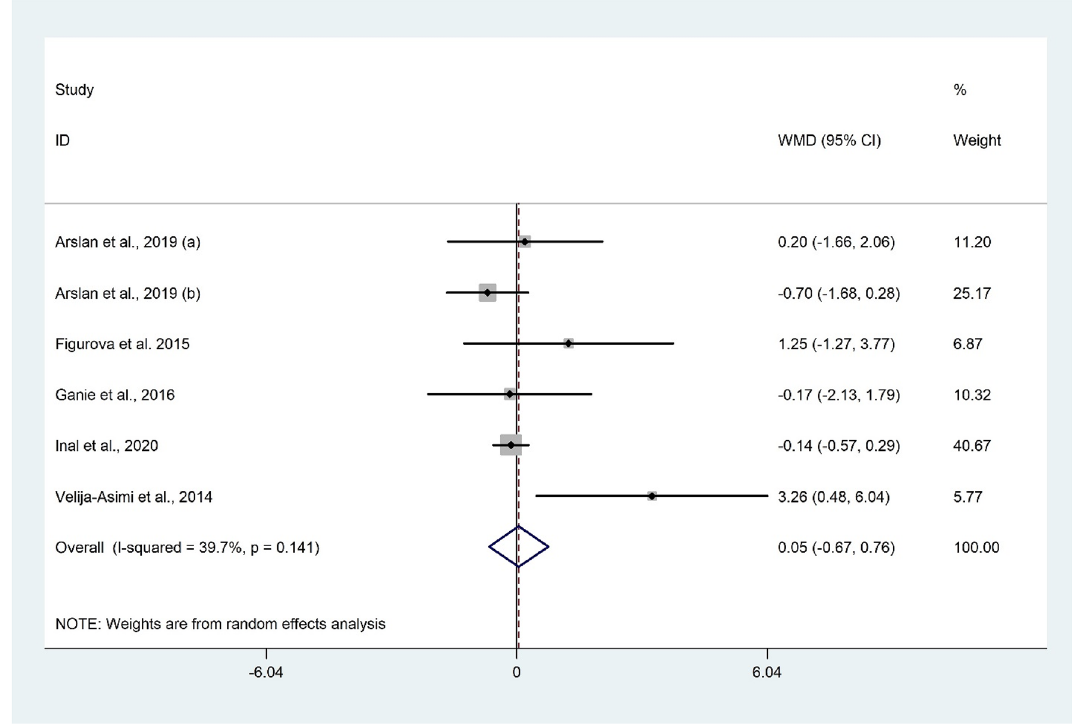
Figure 5. Forrest plot of the comparison of the LH between women with vitamin D insufficiency/deficiency and sufficient ones.